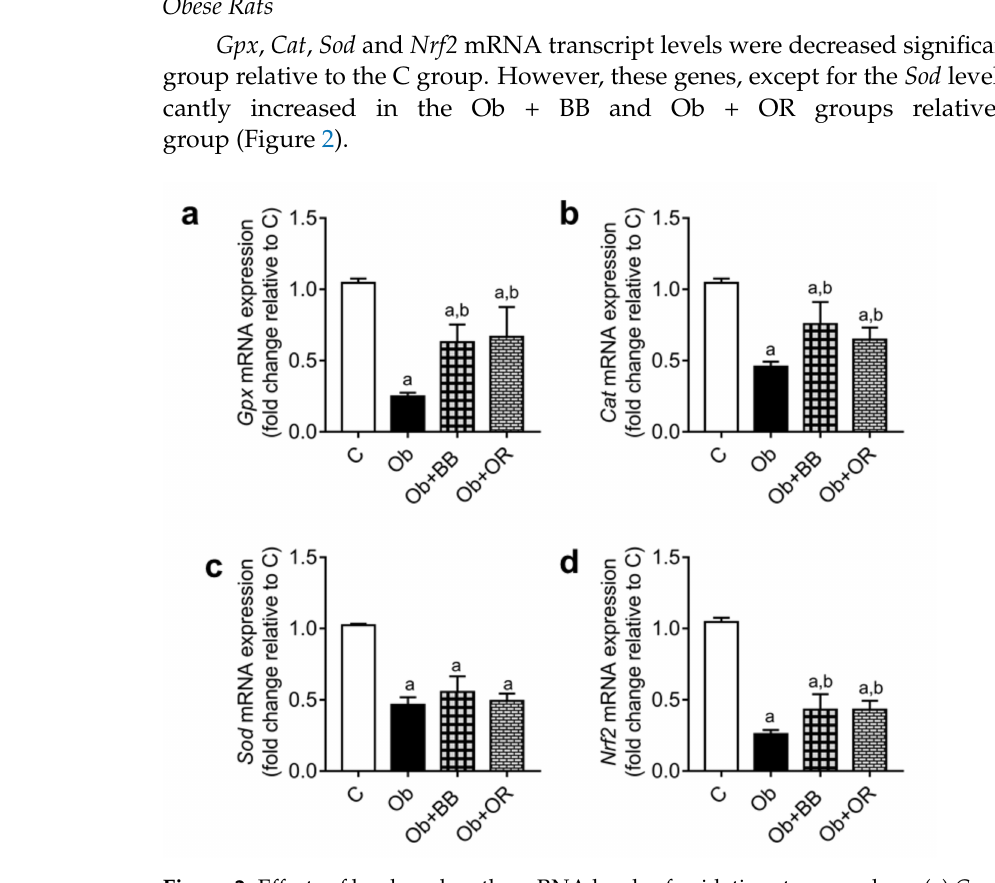
Figure 2. Effects of bee bread on the mRNA levels of oxidative stress markers; ( a ) Gpx , ( b ) Cat , ( c ) Sod , and ( d ) Nrf2 in the testes of obese rats. Gpx : glutathione peroxidase, Cat : catalase, Sod : superoxide dismutase, Nrf2 : nuclear factor erythroid 2-related factor 2, C: control, Ob: obese rats, Ob +